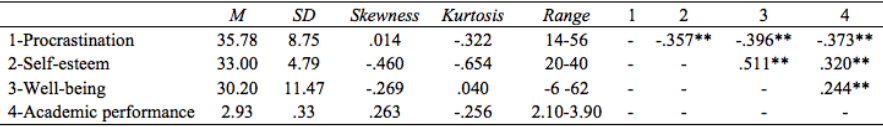
Bivariate correlations and descriptive statistics